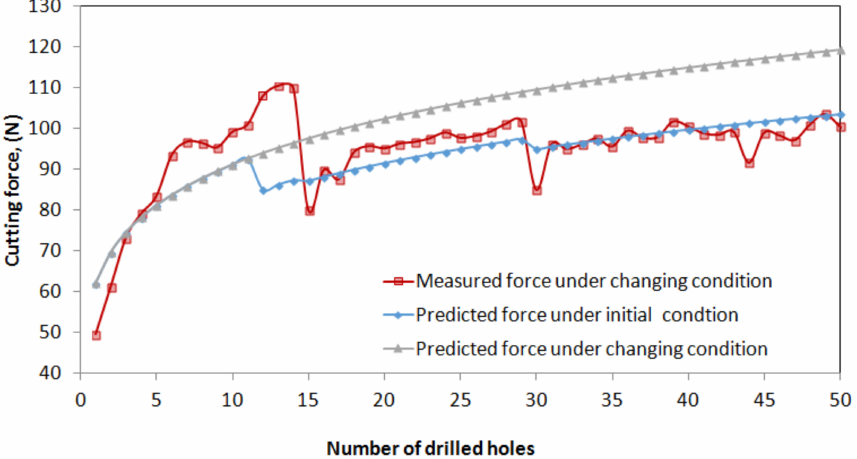
Figure 15. Comparisons of the measured cutting force during the drilling process and the predicted